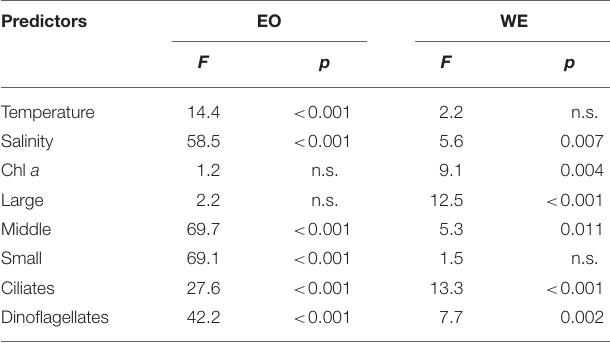
TABLE 2 | Coefficients ( F ) and significance levels ( p ) of the effects of variable predictors on mesozooplankton carnivory using Generalized additive model test.